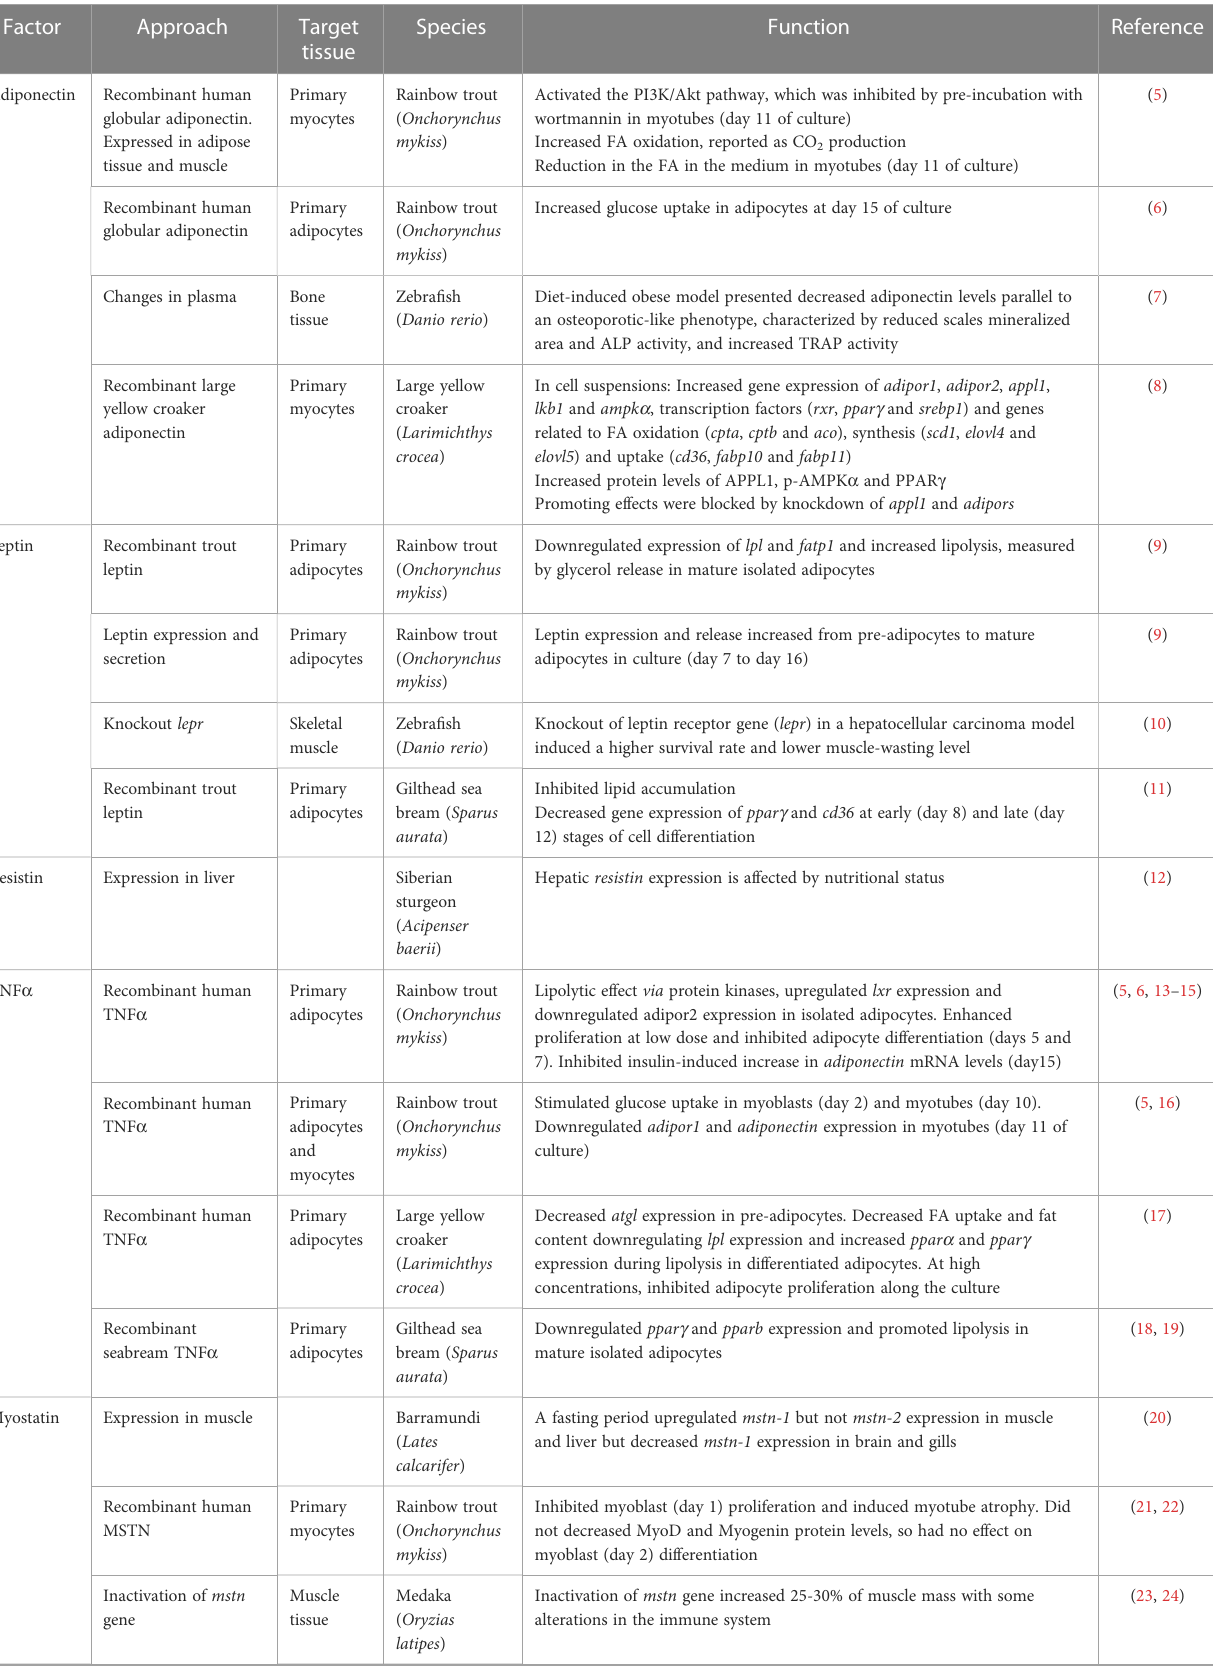
TABLE 1 List of reported adipokines and myokines in fi sh with summarized function in the crosstalk between tissues.